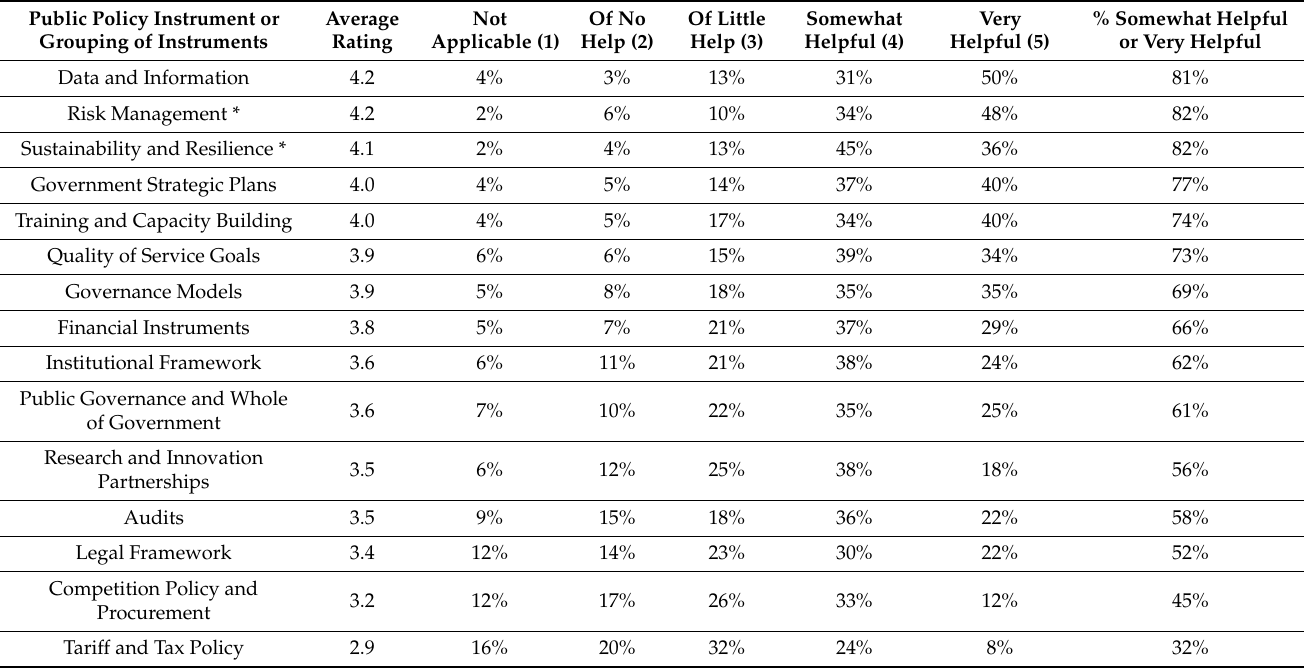
Table 8. Public policy instruments and how helpful guidance would